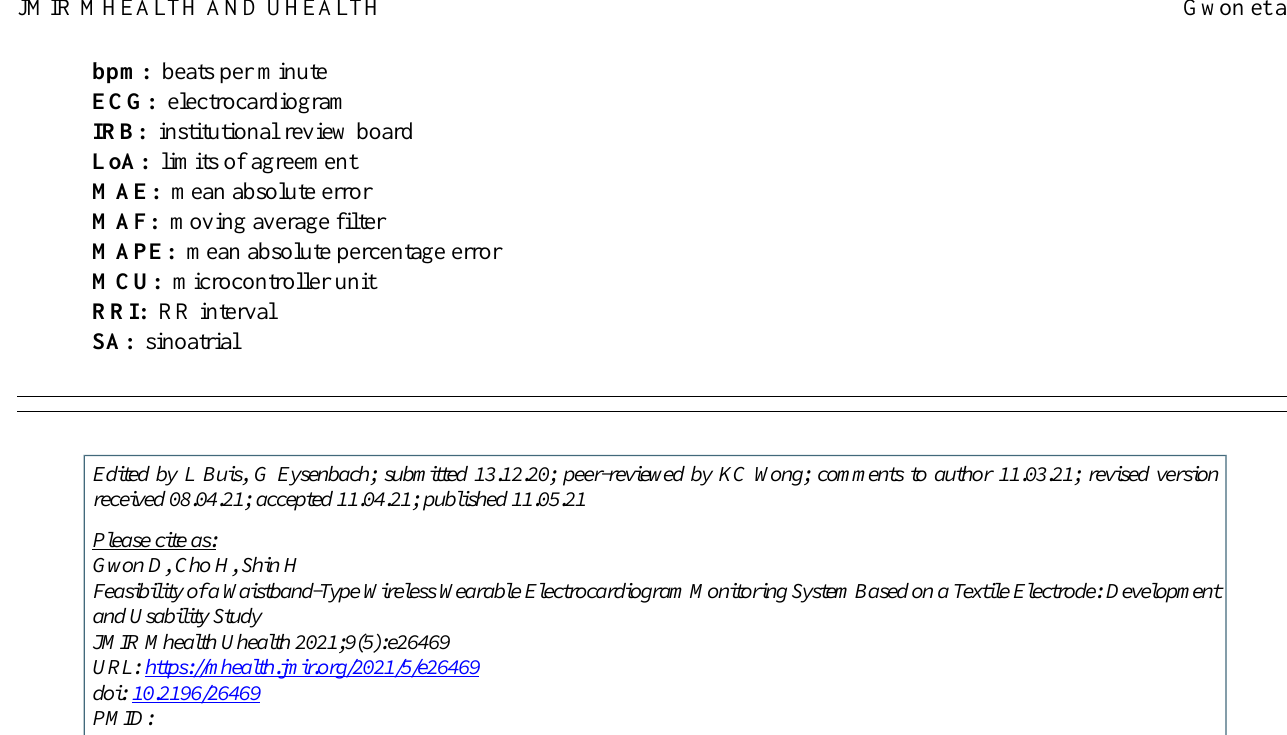
bpm: beats per minute ECG: electrocardiogram IRB: institutional review